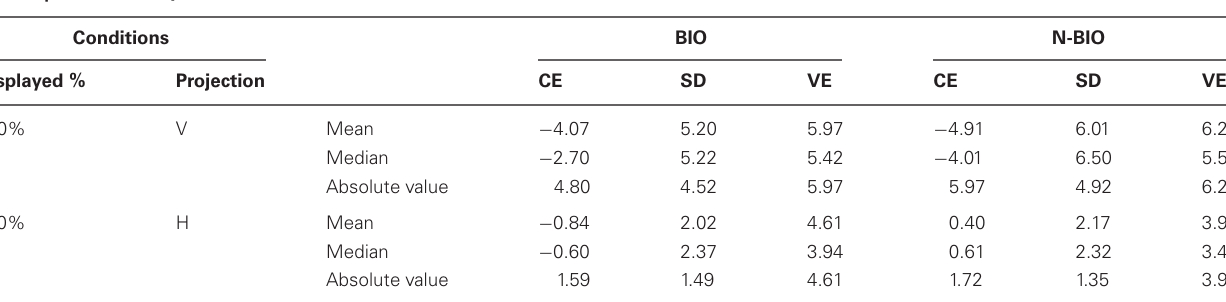
Table 2 | Results of Experiment